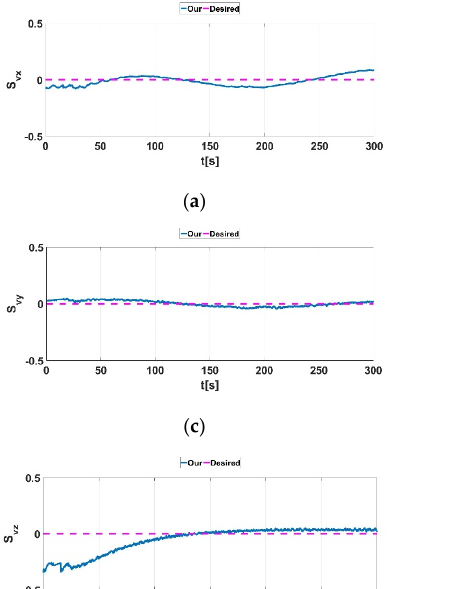
Figure 9. Inner − loop PID sliding surface 𝑺 𝑃𝐼𝐷 . ( a ) 𝑆 𝑥 ; ( b ) 𝑆 𝜑 ; ( c ) 𝑆 𝑦 ; ( d ) 𝑆 𝜃 ; ( e ) 𝑆 𝑧 ; ( f ) 𝑆 𝜓 .